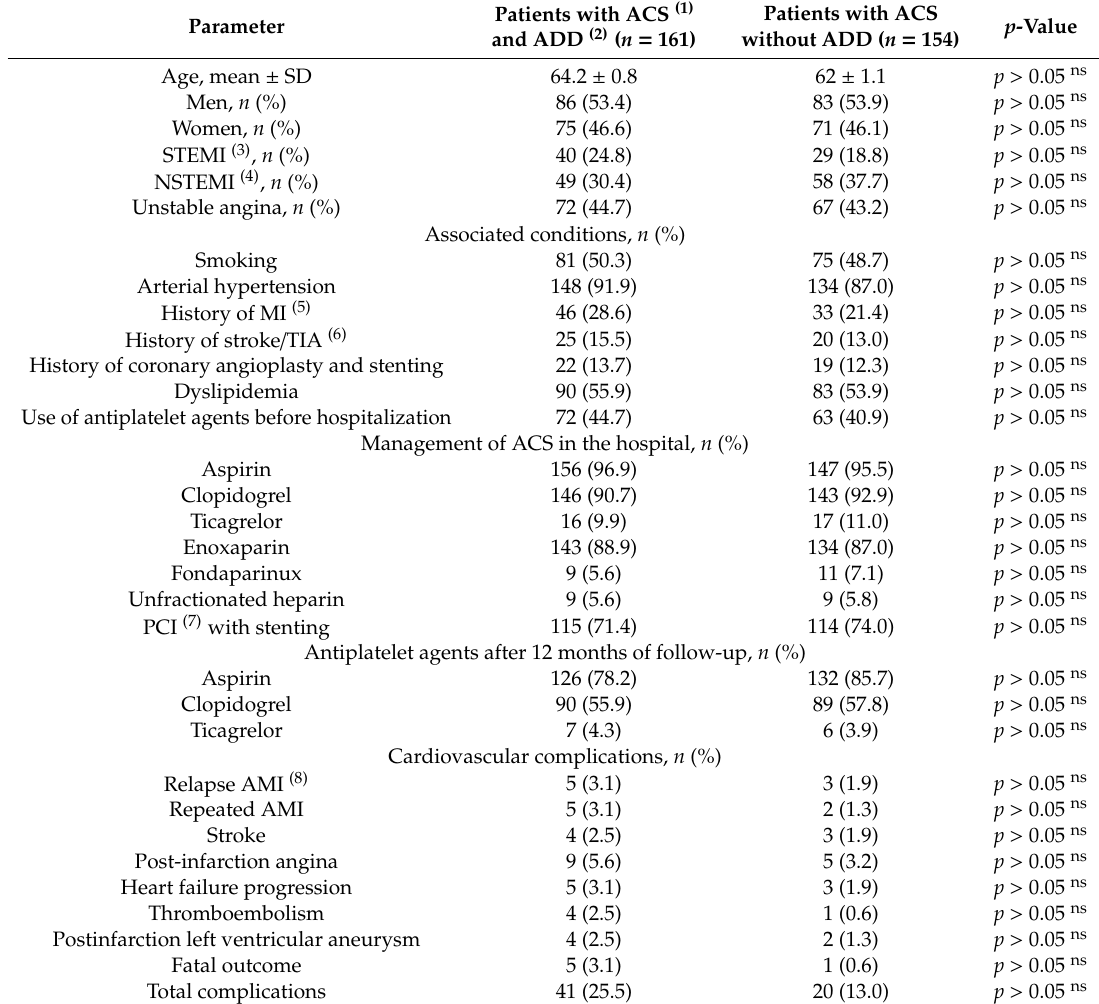
Table 1. Patient characteristics and results of patient follow-up 12 months after inclusion in the